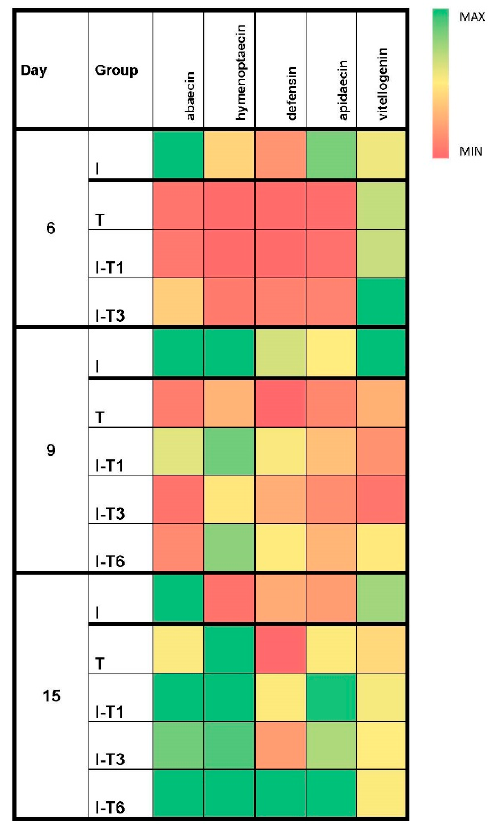
Figure 3. Heat map of median values for the relative genes’ expression levels (abaecin, hymenop- taecin, defensin, apidaecin, and vitellogenin) at different time points (day 6, 9, and 15) in the experimental groups. Group infected with N. ceranae (I), group that was non-infected but treated with thymol (T), groups infected with N. ceranae and treated with thymol from day 1 (I-T1), day 3 (I-T3), and day 6